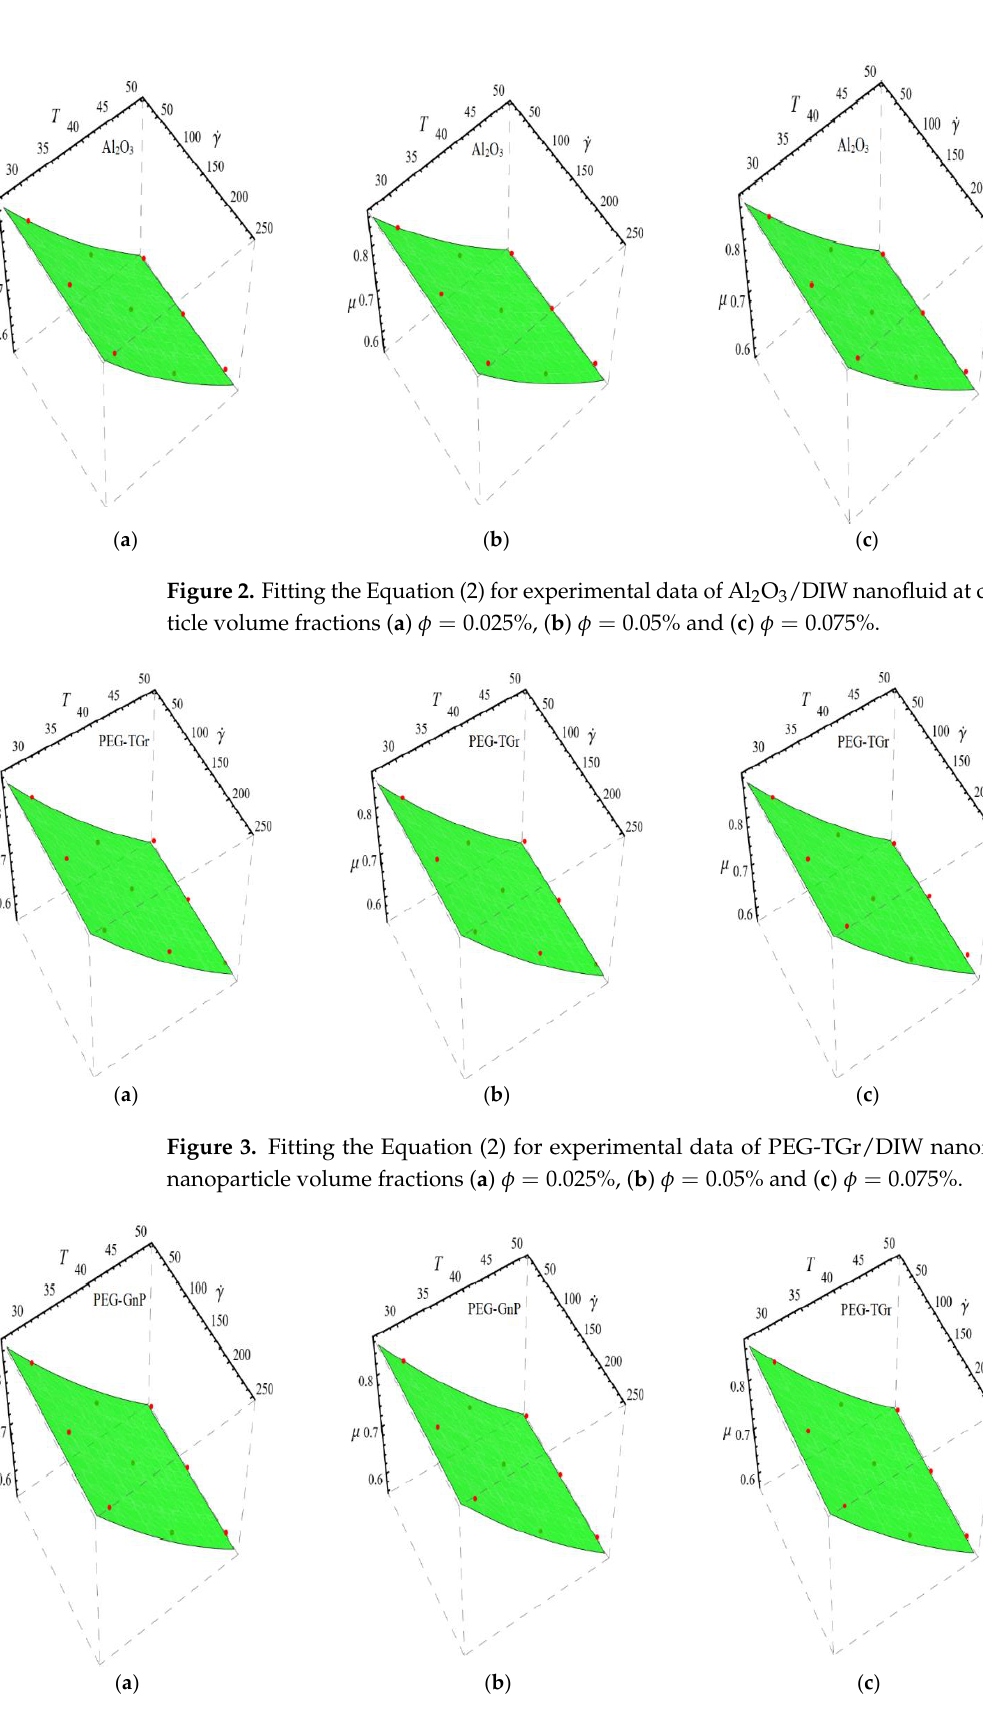
Figure 1. Fitting the Equation (2) for experimental data of SiO 2 /DIW nanofluid at different nanopar- ticle volume fractions ( a )